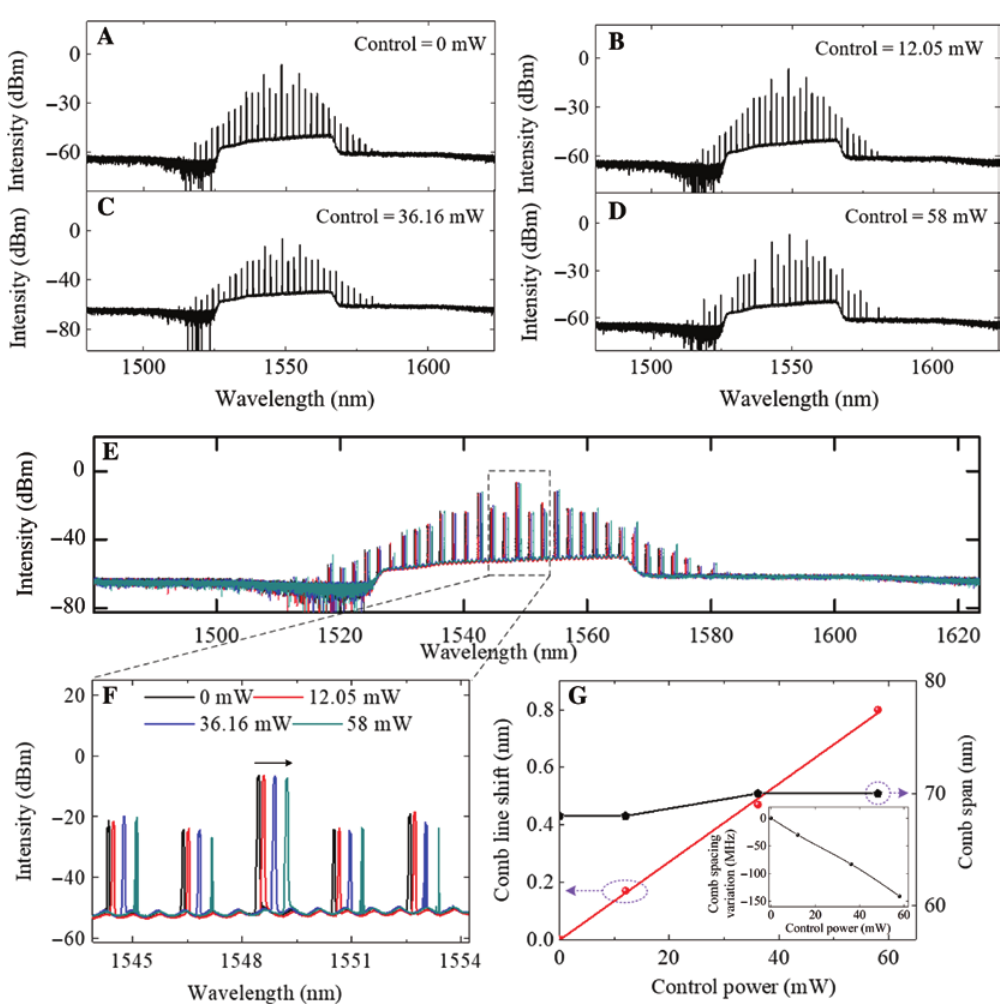
Figure 4: Controllable Kerr frequency comb. (A–D) Kerr frequency combs for different control powers. (E) Tuning of the Kerr frequency comb line with the increase of the control power. (F) Zoom-in spectrum of Figure 4E. (G) Comb line shift (red line), comb span (black line), and comb spacing variation (the inset) vs. the control